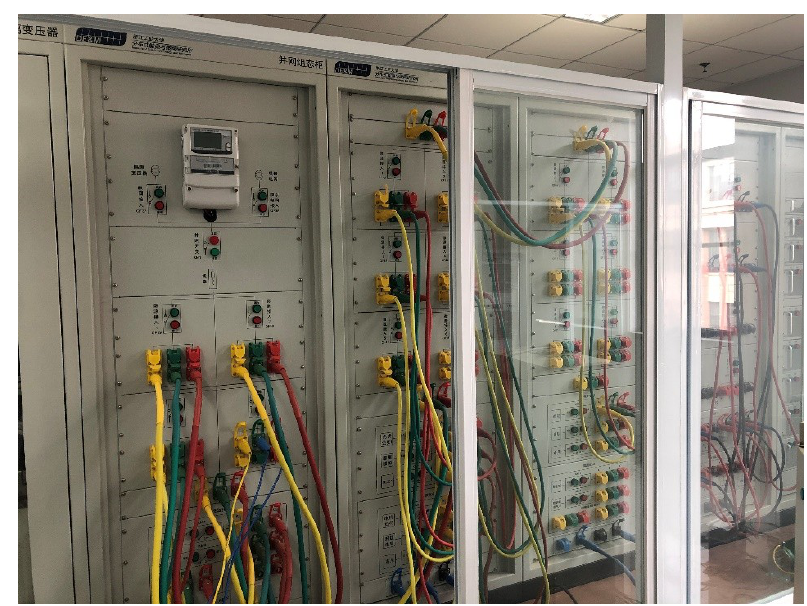
Figure 4. Experimental setup for power quality disturbances.